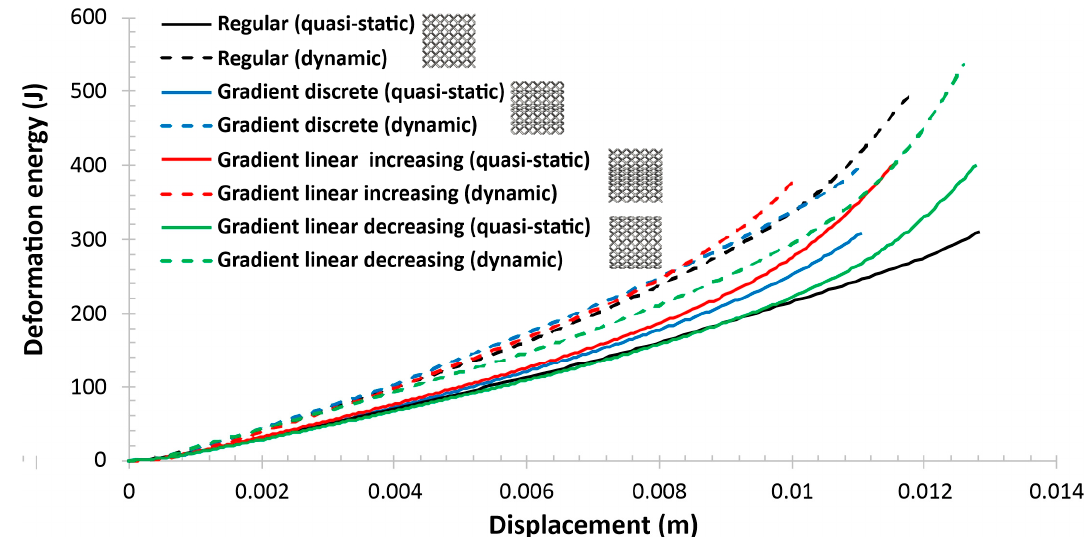
Figure 19. Comparison of compression force history plots obtained in quasi-static and impact compression tests.